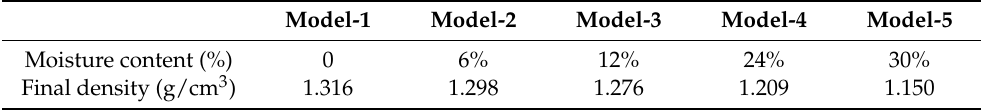
Table 2. Final density of systems with different humidity.